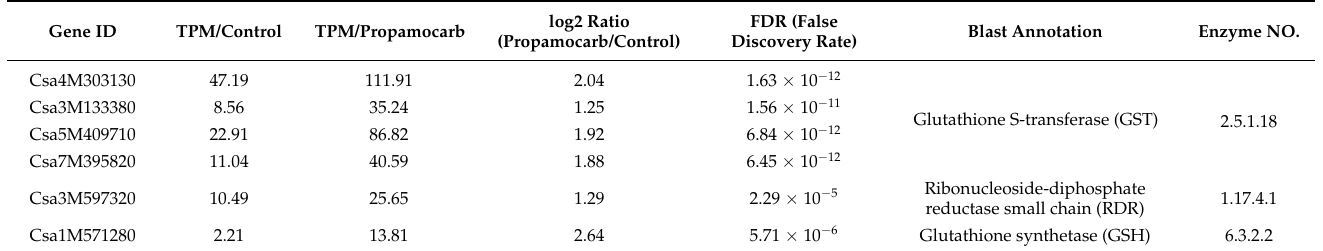
Table 1. List of six genes of the glutathione